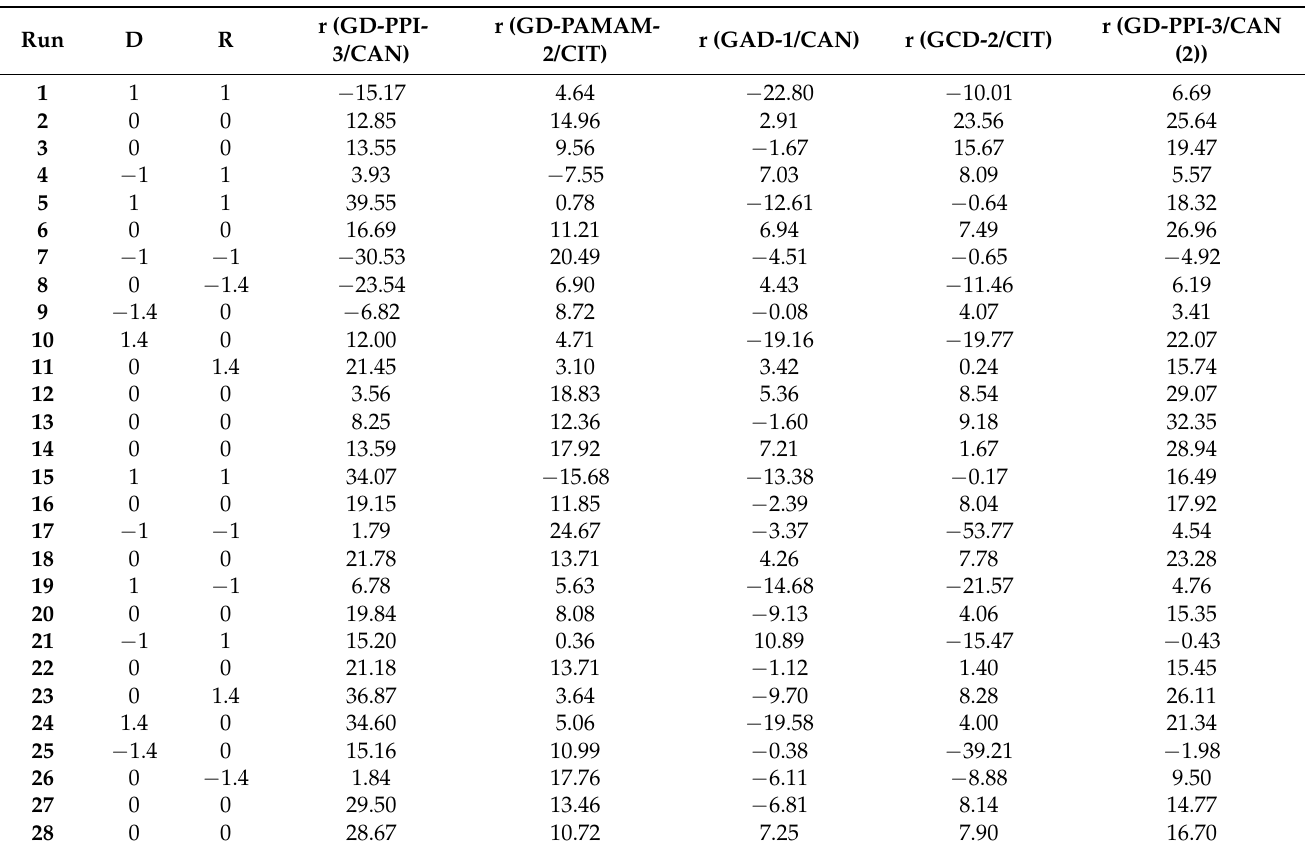
Table 4. Experimental setting (28 runs) generated by Minitab ® 19 and retention rate for the fourth combinations of dendrimers and EOs (%,